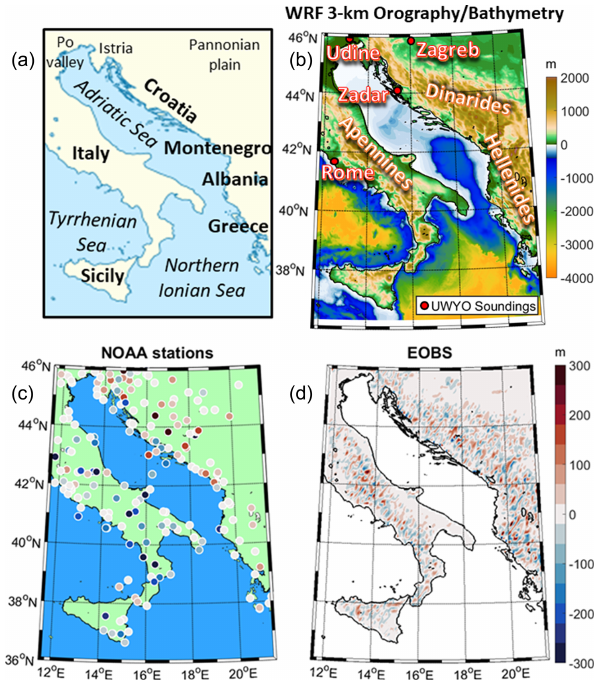
Figure 1. Name of the geographical (a) and orographic and bathy- metric (b) features of the AdriSC WRF 3km model domain, loca- tion of the UWYO soundings (b) , and biases between the AdriSC WRF 3km orography and both the NOAA stations (c) and the E- OBS dataset (d)